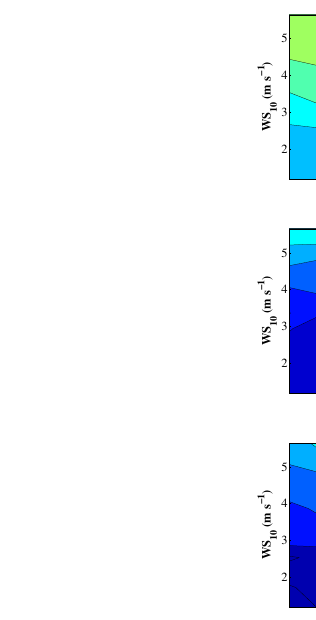
shows that WS 10 has no explanatory value in the pattern of the probability at the 90 % confidence level. The variations between the minima and maxima of the estimated probabili- ties are significant at the 90 % confidence level. However the two modes are hard to distinguish statistically because of the low number of points in our BA data sets (5821 for BA M and 4840 for BA E ). The difference of results between the BA M and BA E probabilities is due to the BA E data set spanning over the 2006–2012 time period, therefore missing the 2003 and 2005 megafire events which are present in the BA M data set (San-Miguel-Ayanz et al., 2013). Regarding fire intensity, FRP is a growing function of WS 10 , (cid:49)T 2 and a decreasing function of (cid:49)N precip , which is significant at the 90 % confi- dence level. The variability linked to (cid:49)T 2 and WS 10 is dis- cussed in Hernandez et al. (2015a) and found back on this figure. Because we use a meteorological covariate depend- ing on past weather ( (cid:49)N precip ), a seasonal preconditioning of high fire risk can be assessed. When a drought occurs in the past months ( (cid:49)N precip ≤ − 7 days) the highest probabil- ities of large BA can be found for high values of both (cid:49)T 2 and WS 10 (Fig. 3). For higher values of the past months pre- cipitation anomaly ( (cid:49)N precip ≥ 7 days), the highest risk cor- responds to heatwaves, with high (cid:49)T 2 and low WS 10 . This difference could be exploited to adapt fire mitigation strate- gies and take into account seasonal weather information.